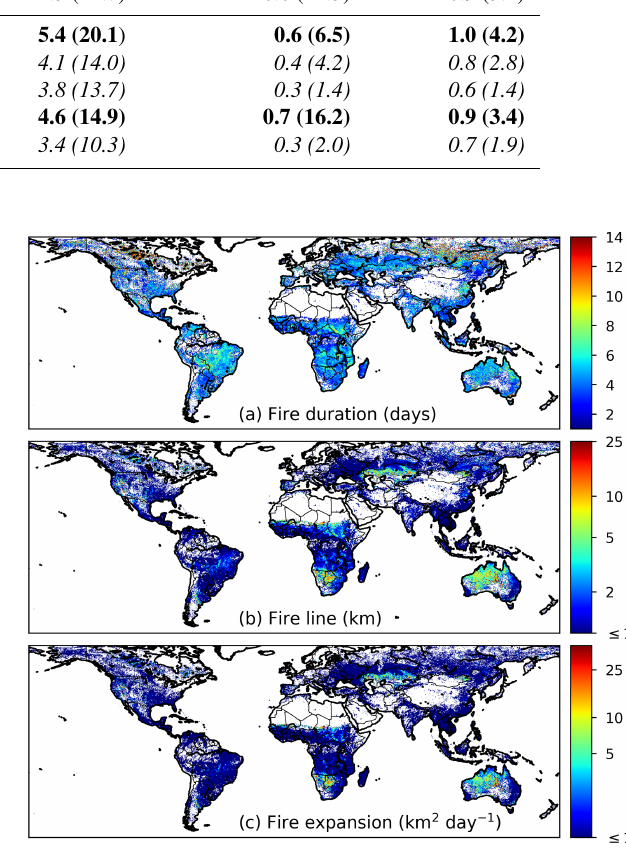
Figure 9. Average fire duration (a) , fire line length (b) and daily ex- pansion (c) over the study period 2003–2016. Fire size (see Fig. 8c) is the product of fire duration (a) and daily fire expansion (c)